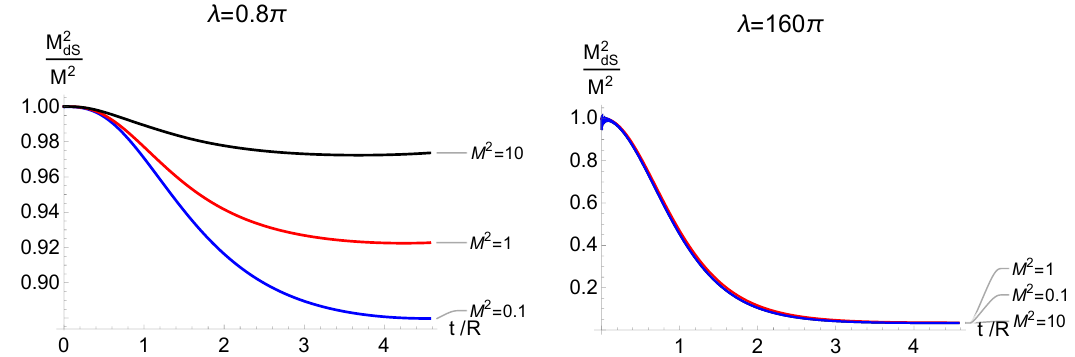
Figure 7 . The e(cid:11)ective mass in dS-frame as a function of global de Sitter time for three di(cid:11)erent values of the renormalized mass parameter M 2 coupling. At strong coupling, the 3 distinct curves for M 2